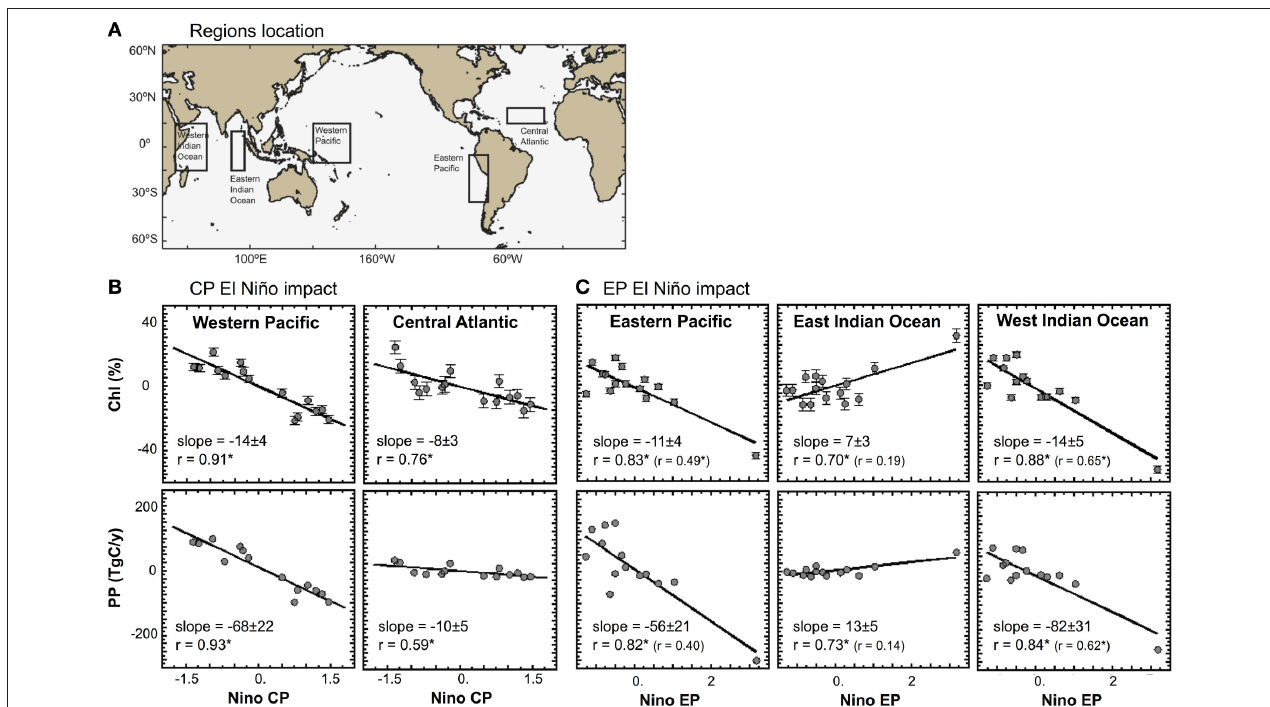
FIGURE 5 | Regional impacts of ENSO climatic perturbations during the period 1997–2012. (A) Location of the areas used in the estimation of regional EP and CP El Niño impact during the period 1997–2012; (B) Annual mean relative anomalies of Chlorophyll (in %) vs. EP index, and annual mean anomalies of Primary Production (in TgC/y) versus EP index; and (C) Annual mean relative anomalies of Chlorophyll (in %) versus CP index, and annual mean anomalies of Primary Production (in TgC/y) vs. CP index. The slope is provided ± Standard Error. Significant Pearson correlation coefficients at the 90% confidence level are indicated with a star. (B) The Pearson correlation coefficients shown in parenthesis are based on the analyses run without including 1997–1998 El Niño event. (B,C) Error bars for each point indicate the standard error based on the total number of observations in each corresponding box region. The standard error is calculated based on the root-mean-square-difference and bias observations provided in